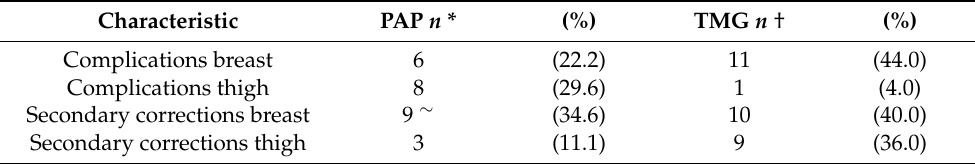
Table 2. Post-operative complications and secondary